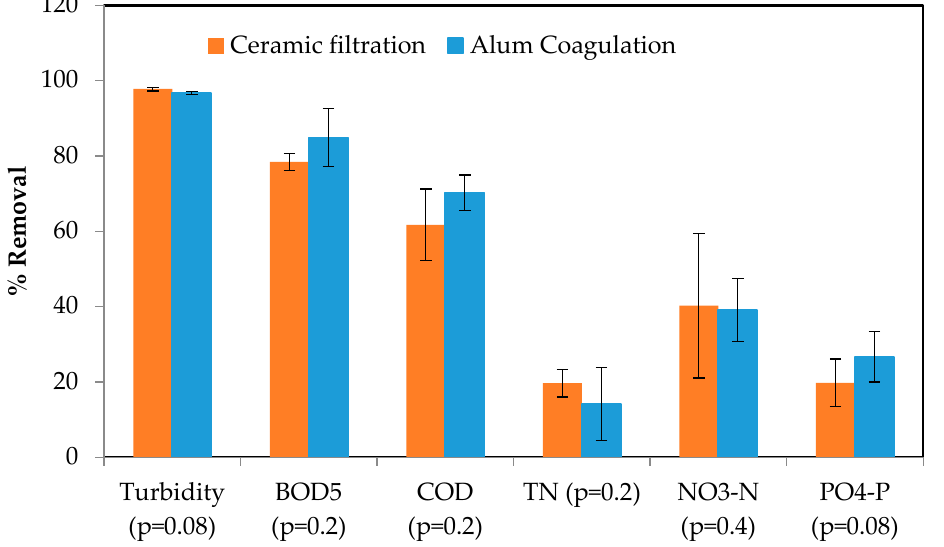
Figure 4. Removal % of turbidity, organics and nutrients by ceramic filtration and alum coagulation. Error bars show the standard deviation of triplicate samples. P values show the statistical significance of the two processes derived from a paired t-test.